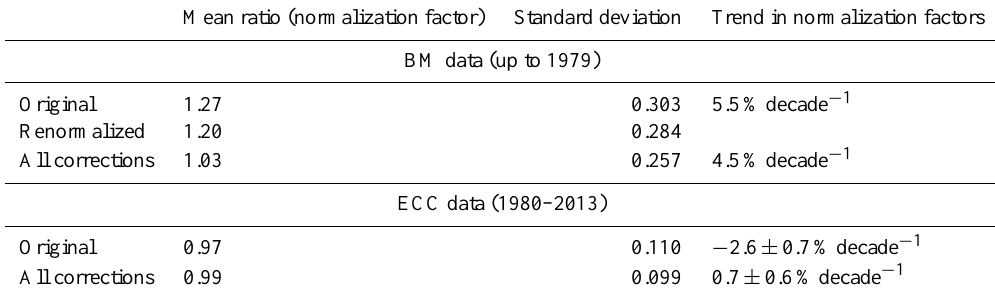
Table 4. Sources of ozonesonde profile error considered in this analysis and their estimated magnitudes. See text for details. Error source Stoichiometry